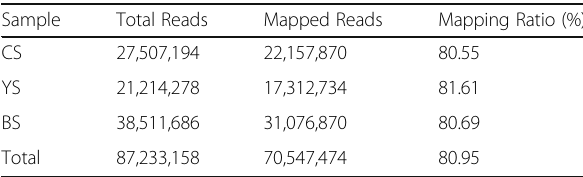
Table 2 Number of Mapped Reads Sample